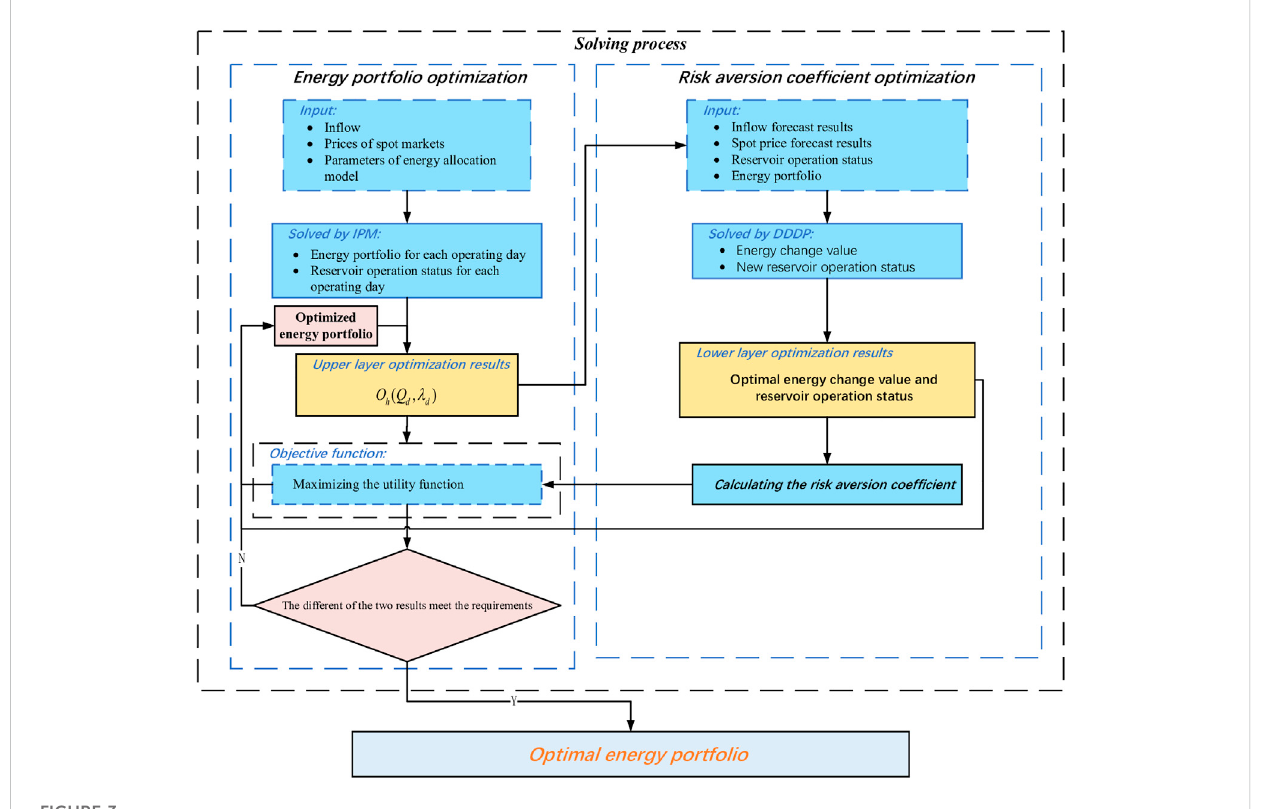
FIGURE 3 Solution process fl ow